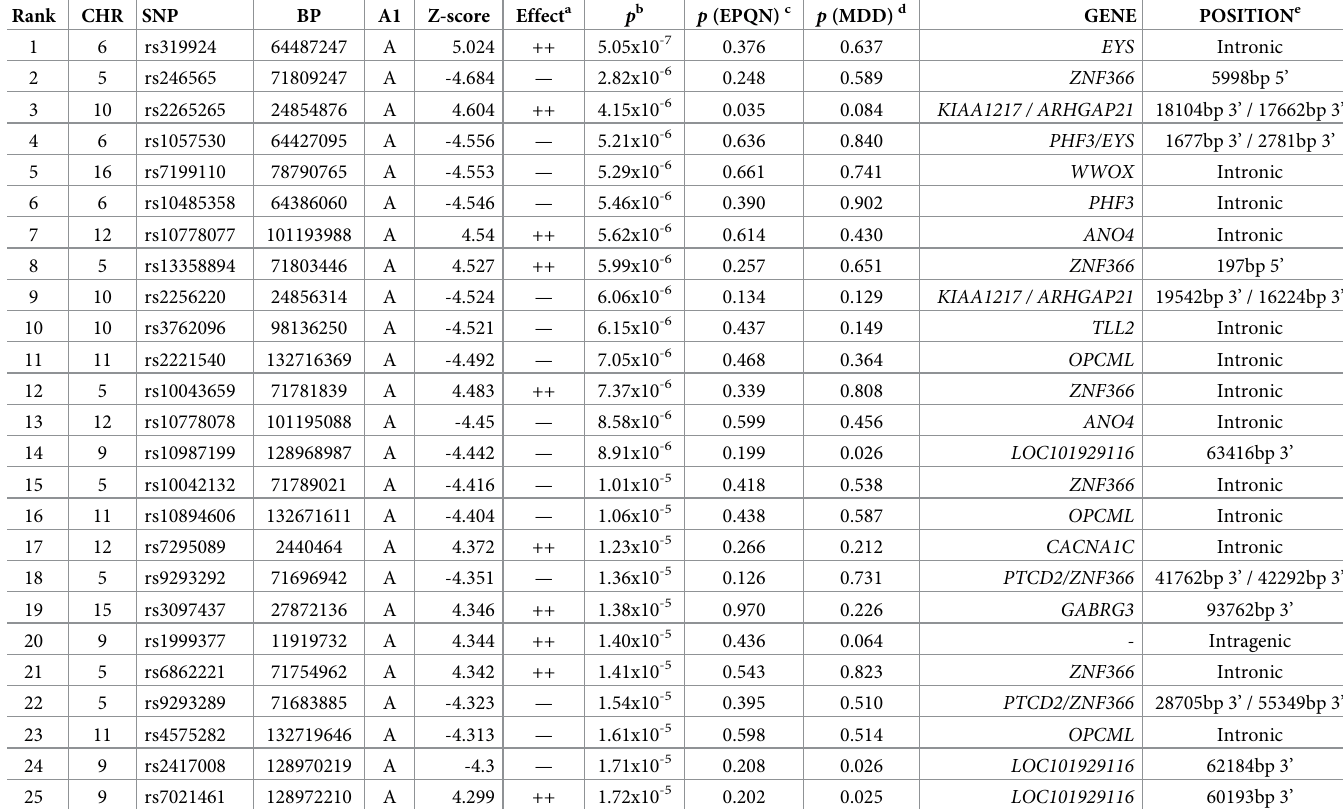
Table 1. Top 25 SNPs from meta-analysis of